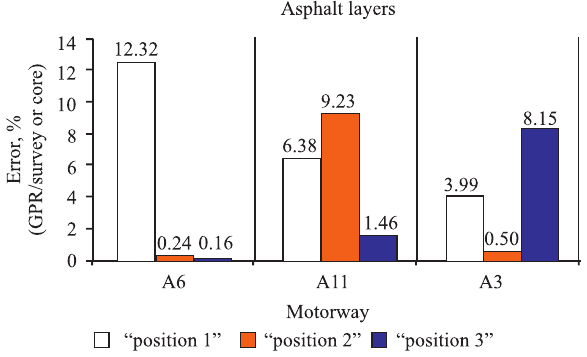
Fig. 4. Comparison to the thickness of asphalt layers on motorways